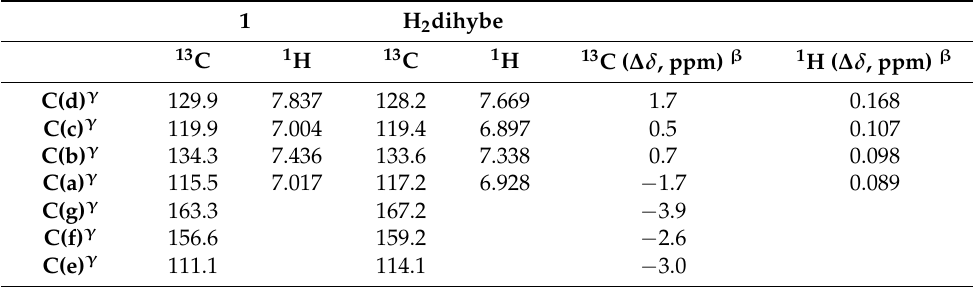
Table 3. 1 H and 13 C NMR chemical shifts (ppm) for the ligand H 3 dihybe, the tetranuclear titanium compound 1 , and the shielding/deshielding effect ( ∆ δ ) upon complexation α .